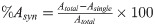
Neutralization of SARS-CoV-2 by mAbs.(A) IC50, IC80, and R squared values for neutralization of pseudo-typed GFP-reporter viral particles. Color code is given below. (B) Inhibition of authentic SARS-CoV-2 infection by the 22 mAbs. Virus infected Vero E6 cells were identified by using anti-nucleocapsid antibody (GeneTex GTX135357) conjugated to AF594 after cell fixation and permeabilization. Infected cells were quantified using Image J. (C) Representative images of cells infected with authentic SARS-CoV-2 in the presence of mAbs. mGO53 is shown as a human isotype mAb control [42]. (D) Cell death induction by SARS-CoV-2 infection. Confluent Vero E6 cells were infected with SARS-CoV-2 at MOI:1 in the presence of mAbs in three concentrations as indicated. Viability of cells in five fields of view was monitored with propidium iodide every 6 h for 60 h using an Incucyte S3. (E) Syncytia formation inhibition as measured by the percentage of fusion area between HEK-293 target cells stably expressing hACE2 and HEK-293T cells transiently expressing SARS-CoV-2-Spike (MN908947.3) in the presence of 10 μg/mL of the appropriate antibody. The cells were incubated for 2 h, prior to imaging by the IncuCyte ZOOM system (Essen BioScience) at hourly intervals over 12 h. The percentage area of syncytia was calculated by subtracting the single cell area from the total field area using the following equation: %Asyn=Atotal−AsingleAtotal×100. (F) AUC quantification of (E). (G) Confocal microscopy image of HEK-293T cells transiently expressing SARS-CoV-2-Spike (MN908947.3) and stained with TAU-2212, followed by incubation with FITC-conjugated anti-human secondary antibody. mGO53 serves as an isotype control [42].